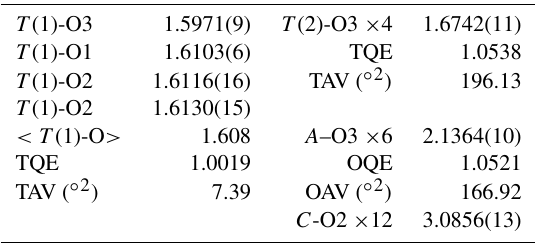
Table 8. Bond lengths (Å) for